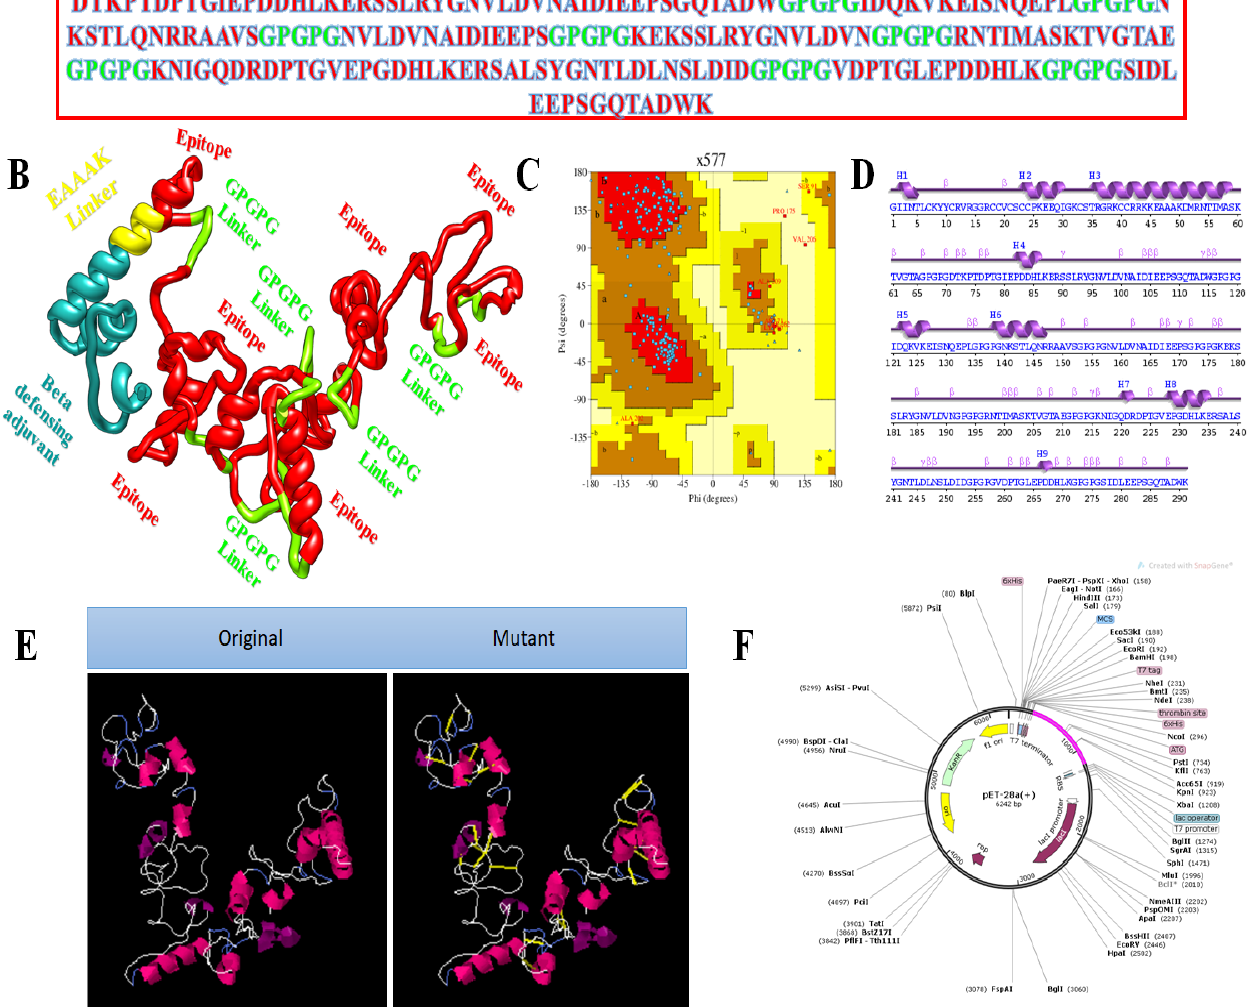
Figure 4. Structure characterisation of model vaccine with β -defensin adjuvant ( A ) amino acid sequence, ( B ) 3D structure of β -defensin vaccine, ( C ) Ramachandran plot, ( D ) secondary structure elements, ( E ) original versus mutated structure, and ( F ) cloned vaccine into expression vector.